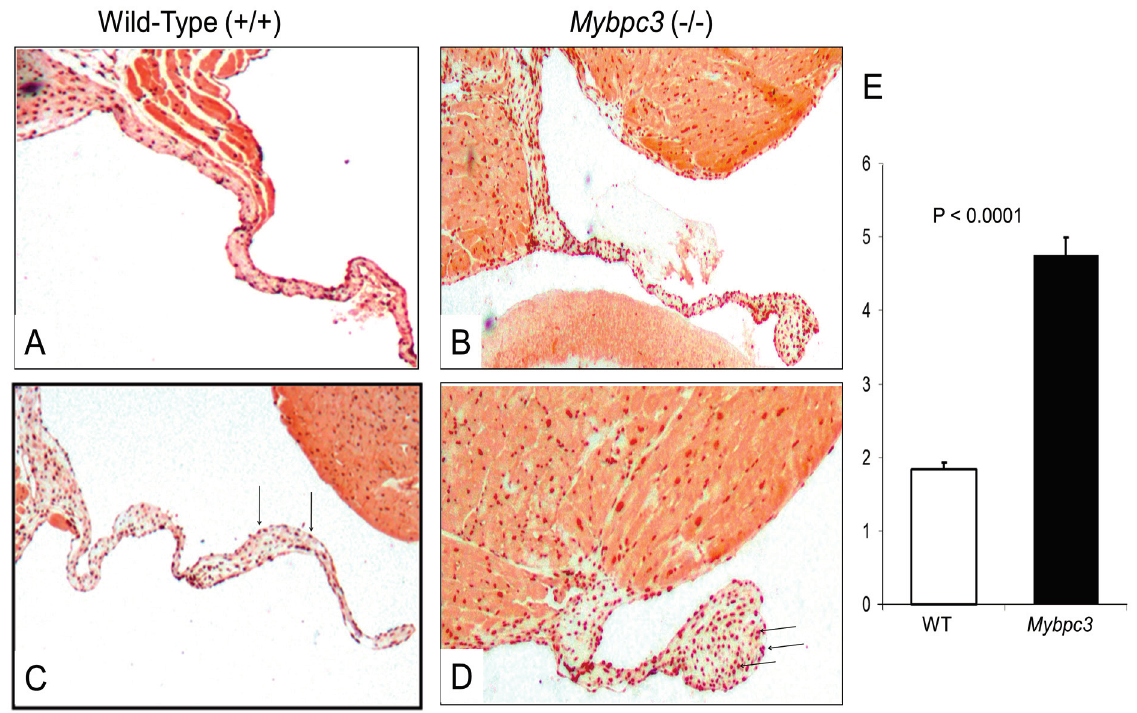
Figure 2. Mybpc3 ( − / − ) MVs have increased nuclear pSmad2. Immunostaining for